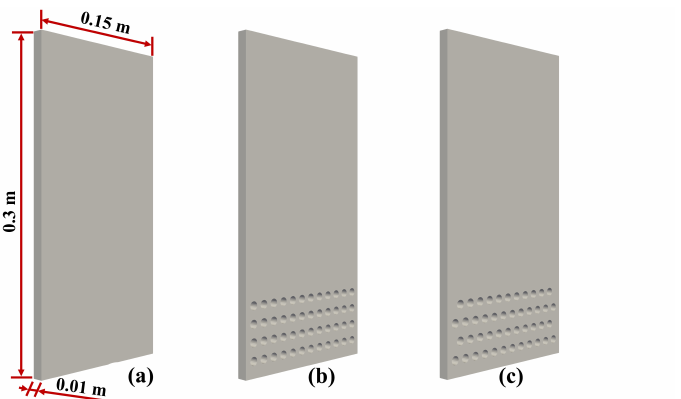
Figure 1. Structure of the fluidized bed methanation reactor. ( a ) without tubes, ( b ) with normal arranged tubes, ( c ) with staggered tubes.